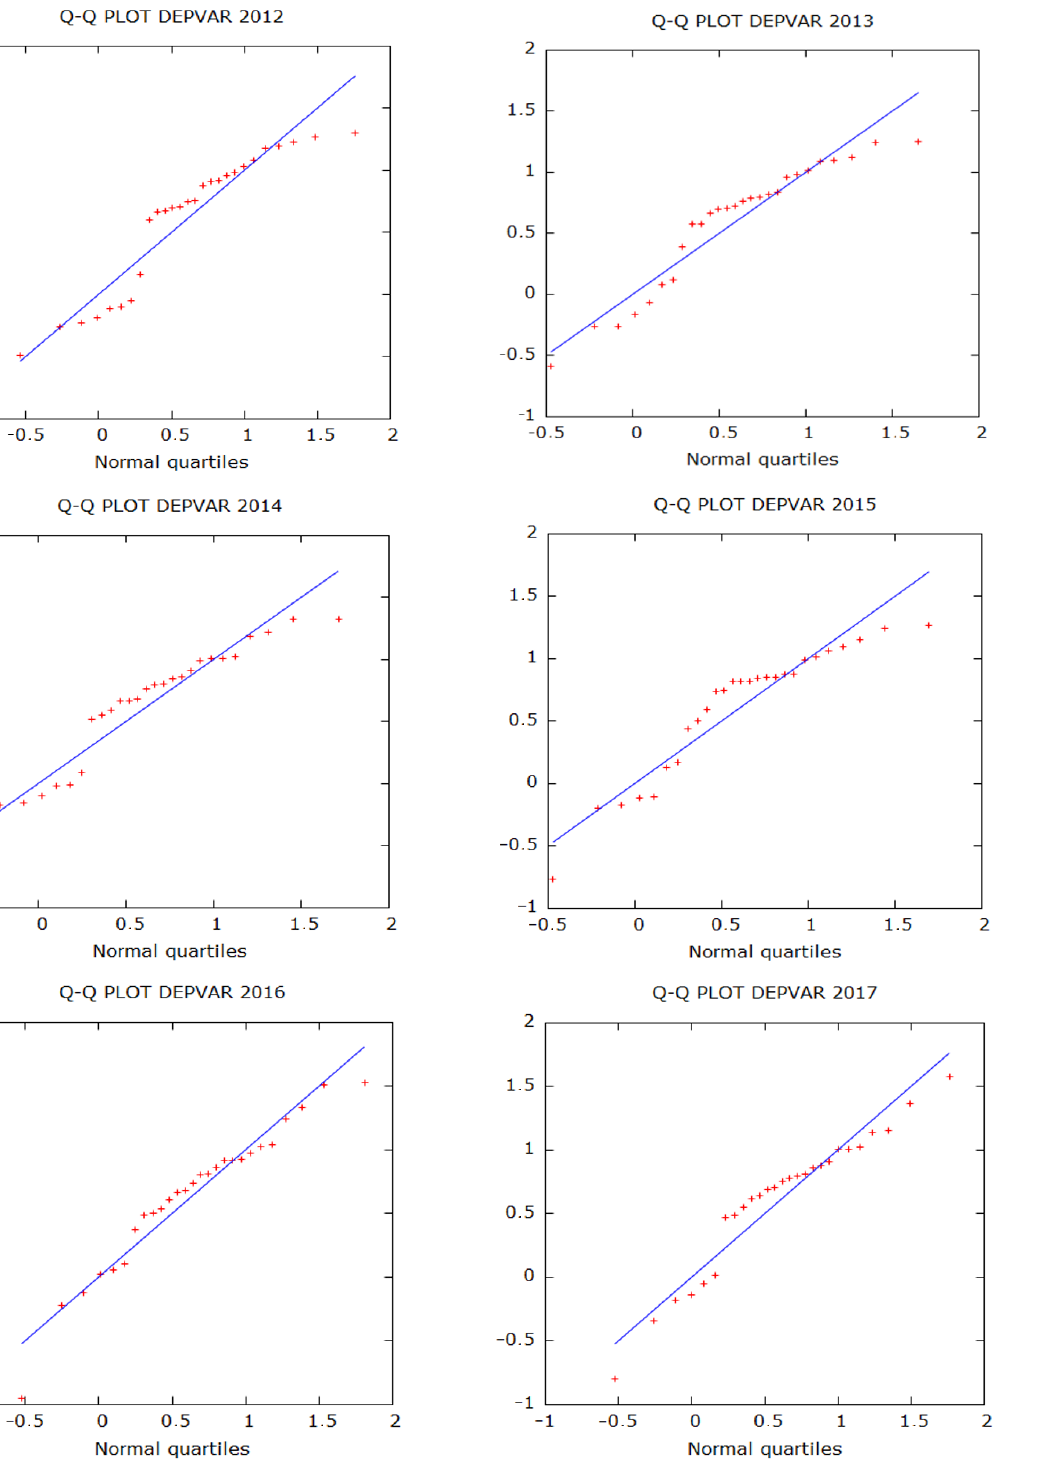
Figure 1. Cont. Figure 1.